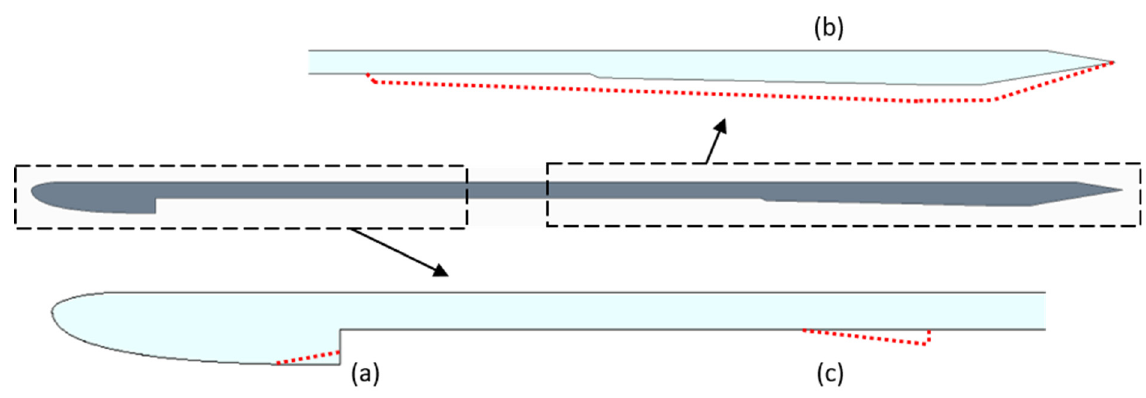
Figure 10. Body shape modifications (shown as dotted red lines) aimed at maintaining long air cavities: ( a ) step trimming for higher speed, ( b ) beach augmentation for higher speed, ( c ) intermediate wedge step for lower speed. Original body form is shown in the middle.